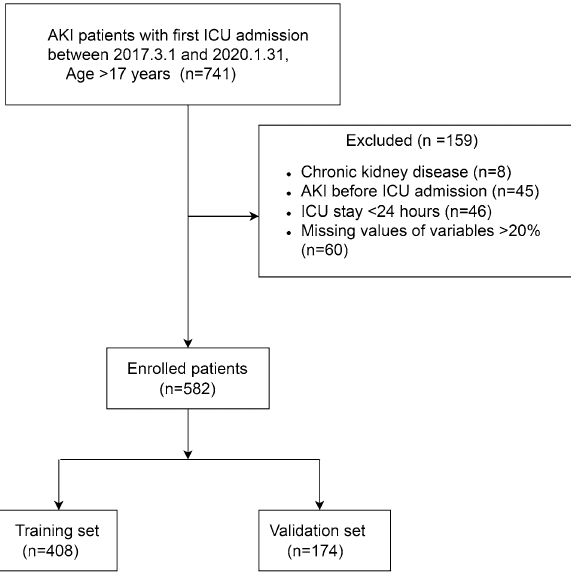
Figure 1. Flow chart of the study. ICU, Intensive Care Unit; AKI, acute kidney